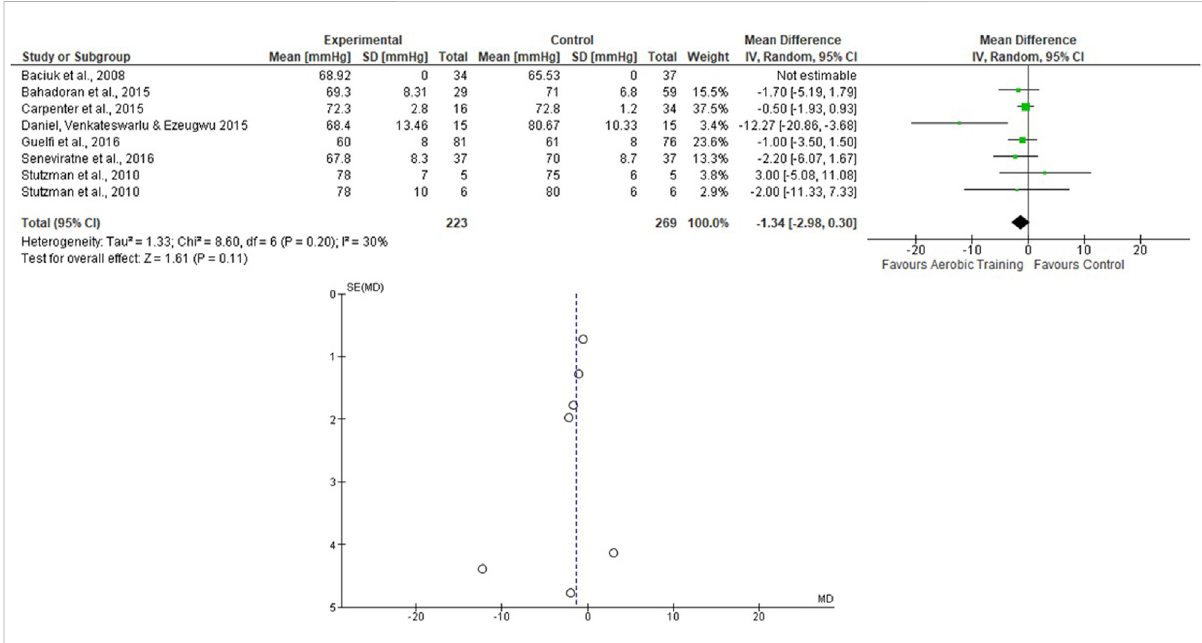
FIGURE 3 Effects of the AT on DBP in pregnant women and funnel plot for detecting bias and systematic heterogeneity.